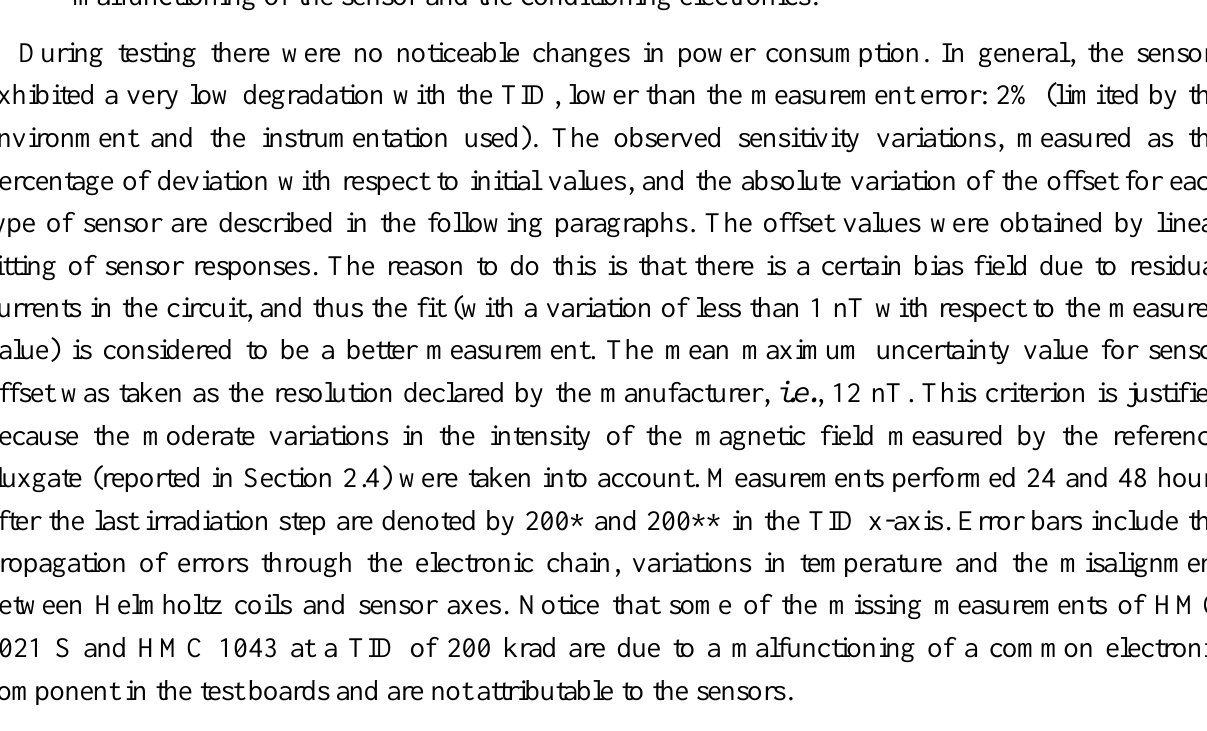
Figure 4. Sensitivity deviation measured for external and internal coil configuration as a function of TID for powered and non-powered HMC 1021